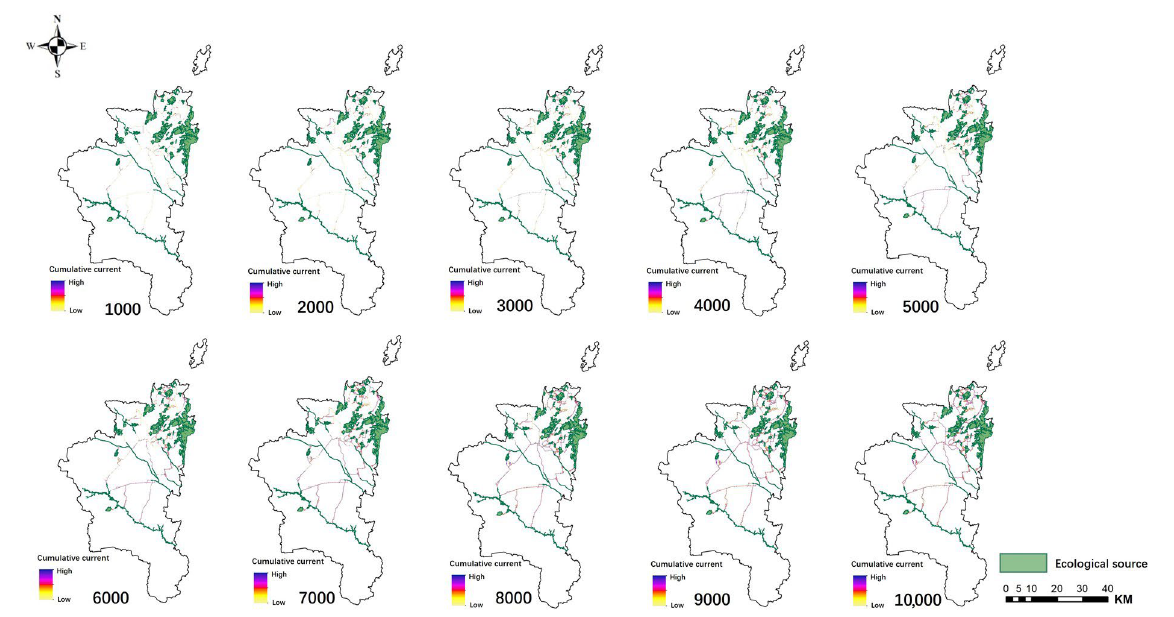
Figure 7. Spatial distribution of ecological corridors for thresholds from 1000 to 10,000.